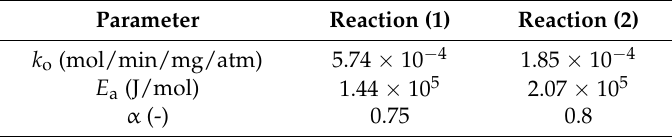
Table 1. Kinetic model parameters for ethanol reforming [23].